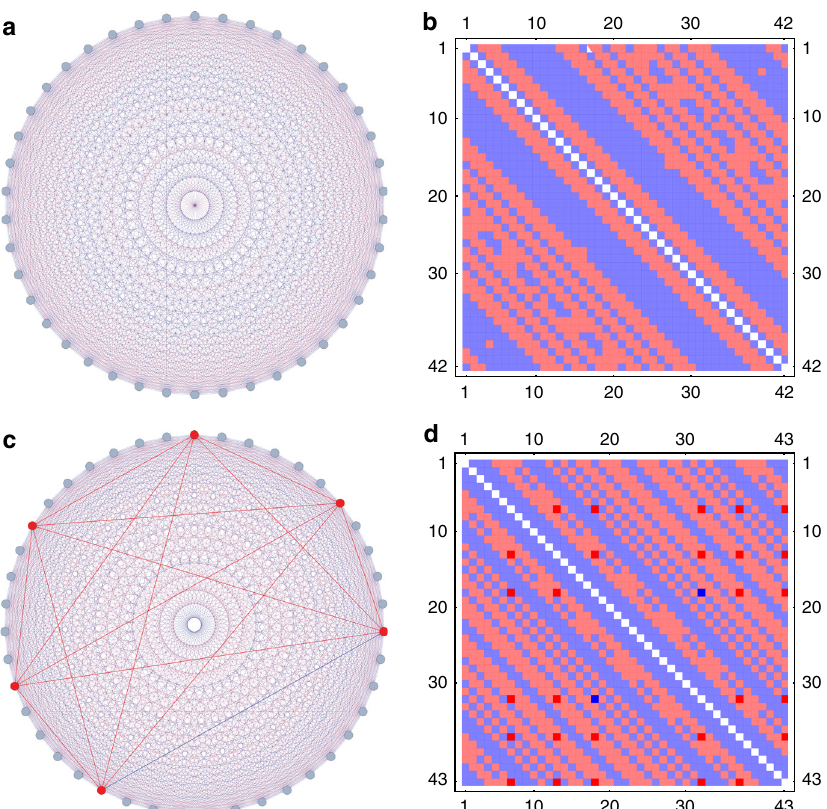
Fig. 7 Colorings for the R (5, 5) Ramsey number problem. a A coloring of the complete graph on N = 42 nodes that avoids monochromatic 5-cliques. b The adjacency matrix corresponding to the coloring in ( a ), using the same colors. c The best coloring of the complete graph on N = 43 nodes containing only 2 monochromatic (red) 5-cliques, sitting on 6 nodes (highlighted with thicker edges). d The adjacency matrix corresponding to the coloring in ( c ), using the same colors. The thicker red (blue) edges from ( c ) are represented with darker red (blue) cells. Supplementary Fig. 9 shows a reordered version of this matrix such that the 5-cliques can be seen in the upper left corner of the